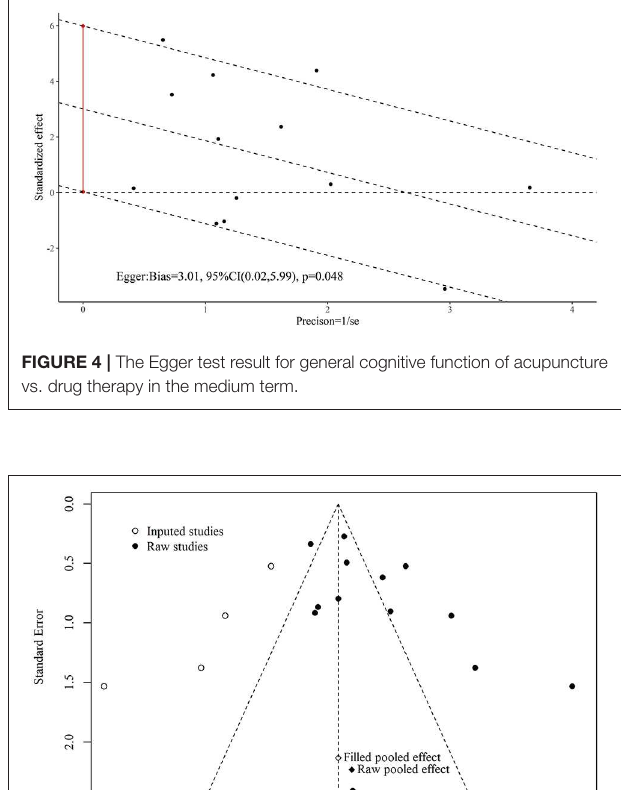
a difference in efficacy between the two groups using the ADAS- cog after long-term